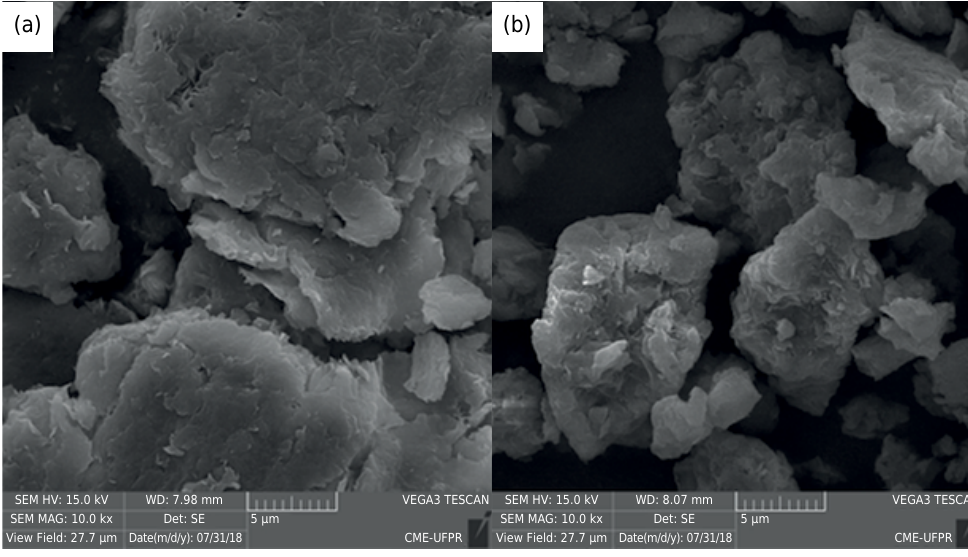
Figure 8. Sample scanning electron microscope (SEM) micrographs of natural MMT (a) and Al0h Li (b).